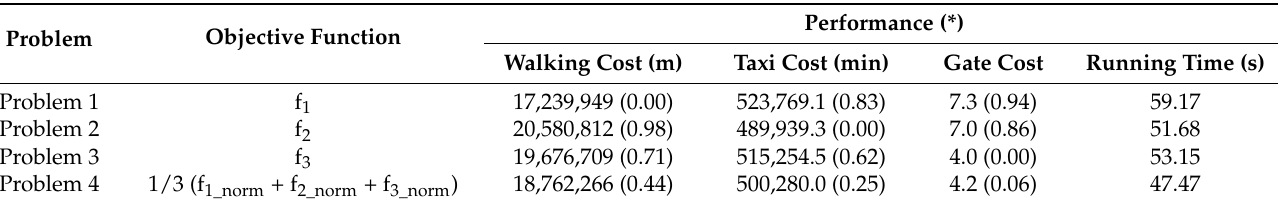
Table 4. Performance comparison of four optimization